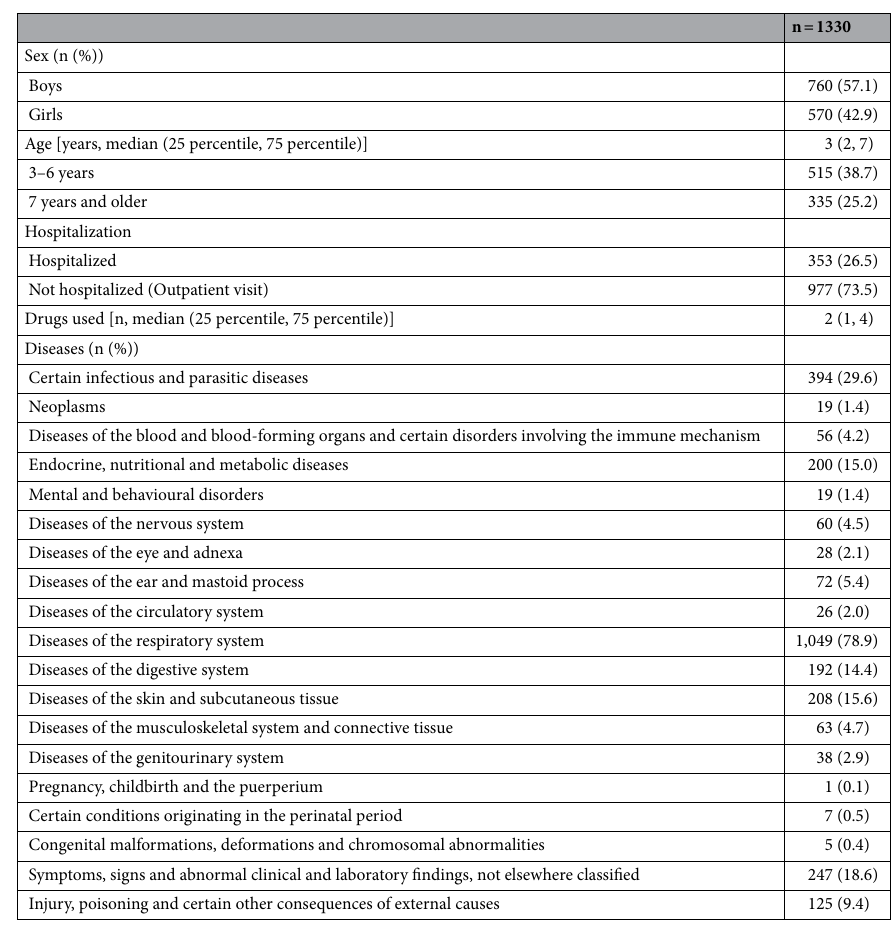
Table 1. Characteristics of the patients. Patients with two or more diseases were counted for each